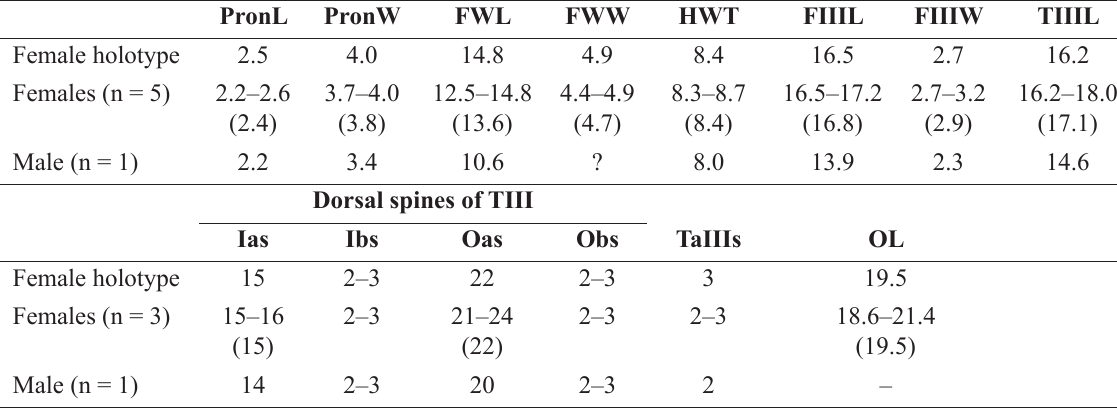
ventral of the thick stripe; stripes never reaching the margins. Fore and middle legs with longitudinal dark stripes. FIII also with longitudinal dark stripes, two dorsally, one on each side; and two ventrally, one on each side. Thoracic (excluding pronotum) and abdominal tergites typically dark or greyish, anterior margin darkest, posterior margin whitish. Cerci whitish with a black stripe.